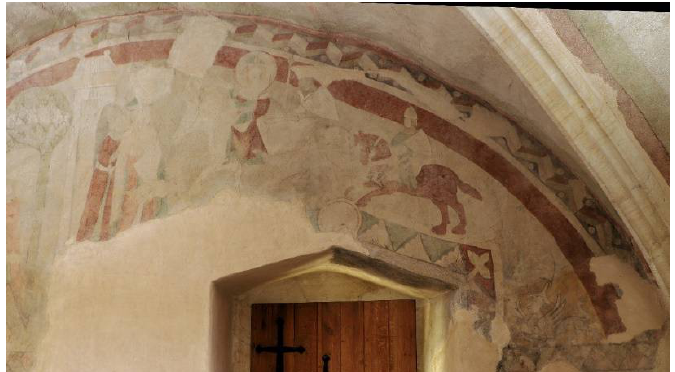
Figure 1. Prague, House at the Stone Bell, Lower Chapel. Cycle of paintings with the legend of St.